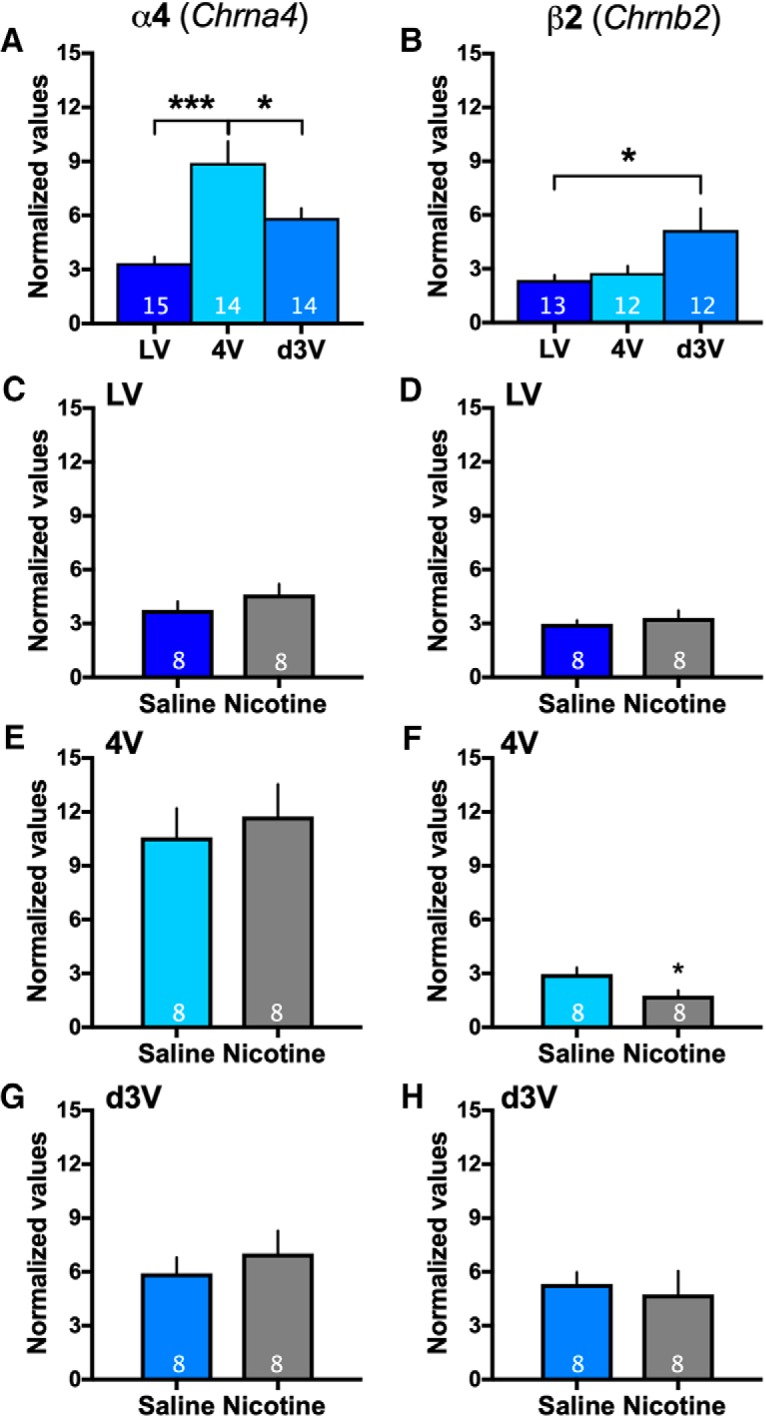
Differential expression of α4 and β2 nAChR subunits across choroid plexus sites. A, B, Given that α4 and β2 subunits were found in all choroid plexus sites, their relative expression was compared under baseline conditions (n = 12–15/group, specific number per group denoted on each bar). A, For the α4 nAChR subunit, significantly increased expression was found in choroid plexus from the fourth ventricle compared to tissue from the lateral and d3V. Post hoc corrected for multiple comparisons; *p < 0.05, ***p < 0.001. Central tendency (mean) and variation (SEM) values for each are as follows: LV: 3.350 ± 0.34; 4V: 8.925 ± 1.18; and d3V: 5.861 ± 0.53. For each nAChR gene, expression data were normalized to expression of β-actin. B, With regard to the β2 nAChR subunit, significantly increased expression was found in the d3V choroid plexus as compared to the lateral ventricle (LV). Post hoc corrected for multiple comparisons; *p < 0.05. Central tendency (mean) and variation (SEM) values for each are as follows: LV: 2.371 ± 0.27; 4V: 2.773 ± 0.38; and d3V: 5.156 ± 1.19). 4V: fourth ventricle. For each nAChR gene, expression data were normalized to expression of β-actin. Data represent mean normalized values ± SEM. C–H, Expression of α4 and β2 nAChR subunits with nicotine or saline self-administration (n = 8/group as denoted on each bar). Following saline or nicotine self-administration in rats, normalized expression levels of α4 and β2 nAChR subunits were compared. For the α4 nAChR subunit (left panels), similar mRNA expression levels were found with saline and nicotine self-administration in choroid plexus from the (C) LV, (E) 4V, and (G) d3V. For the β2 nAChR subunit (right panels), differences were not found in mRNA expression in the (D) LV or (H) d3V, whereas a significant decrease with nicotine was found in the (F) 4V choroid plexus; *p < 0.05. Central tendency (mean) and variation (SEM) values (C–H) are as follows: α4 LV - Saline: 3.758 ± 0.46; Nicotine: 4.600 ± 0.60; α4 4V - Saline: 10.60 ± 1.60; Nicotine: 11.74 ± 1.79; α4 d3V - Saline: 5.915 ± 0.87; Nicotine: 7.015 ± 1.28; β2 LV - Saline: 2.978 ± 0.19; Nicotine: 3.310 ± 0.41; β2 4V - Saline: 2.953 ± 0.37; Nicotine: 1.762 ± 0.30; β2 d3V - Saline: 5.319 ± 0.66; and Nicotine: 4.732 ± 1.31. For each nAChR gene, expression data were normalized to expression of β-actin. Data represent mean normalized values ± SEM.